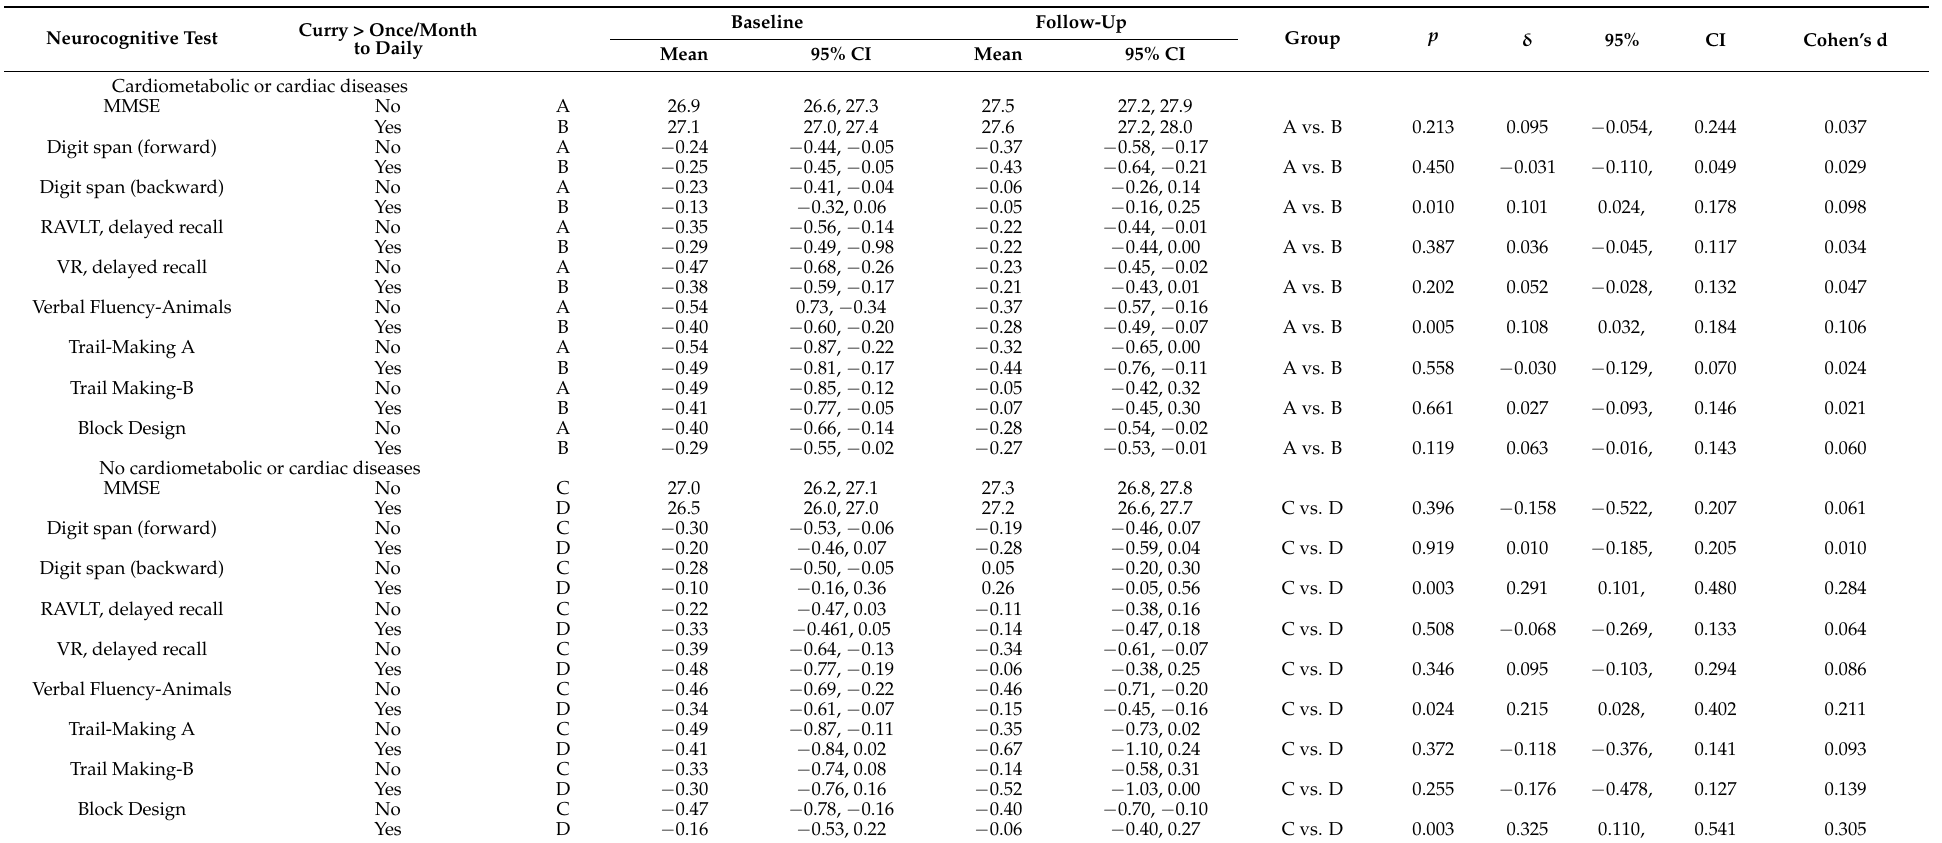
Table 4. Mixed linear model analyses: covariate-adjusted mean neurocognitive z-scores at baseline and follow-up by cardiometabolic morbidity and curry consumption